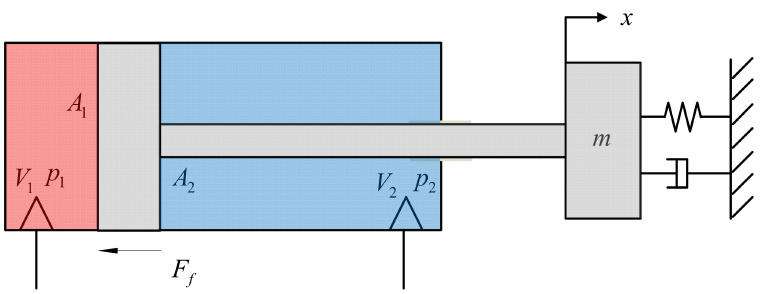
Figure 8. Schematic of hydraulic